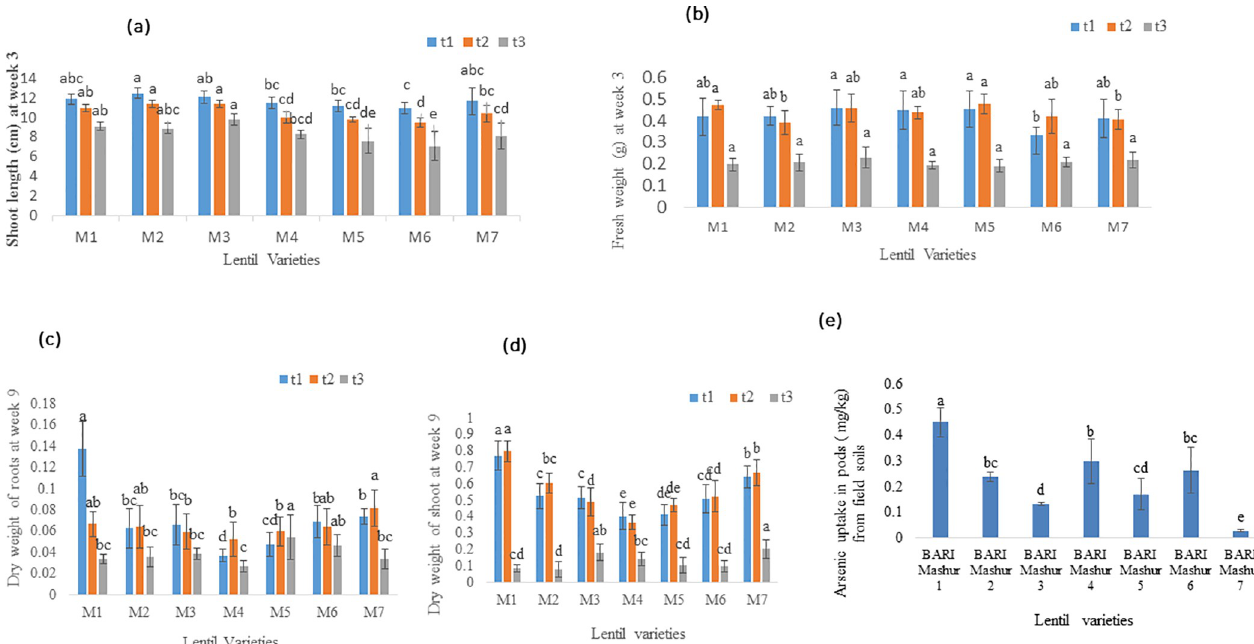
Fig 1. Effect of arsenic uptake on a) shoot length (Mean ± SEM), b) fresh weight (Mean ± SEM) of lentil varieties at week 3; c) dry weight of roots (Mean ± SEM), d) dry weight of shoots (Mean ± SEM) of lentil varieties at week 9; e) Average arsenic accumulation in lentil grains (Mean ± SEM) from arsenic contaminated field soils . Means denoted by different letters under the same As level indicate significant difference at 0.1% level of significance. M 1 , M 2 , M 3 , M 4 , M 5 , M 6 and M 7 indicate BARI Mashur 1, BARI Mashur 2, BARI Mashur 3, BARI Mashur 4, BARI Mashur 5, BARI Mashur 6, & BARI Mashur 7, lentil genotypes, respectively. Arsenic treatments indicate concentration of arsenic in soil; t1, control, 5mg arsenic kg -1 soil; t2, 15 mg arsenic kg -1 soil; t3, 100 mg arsenic kg -1